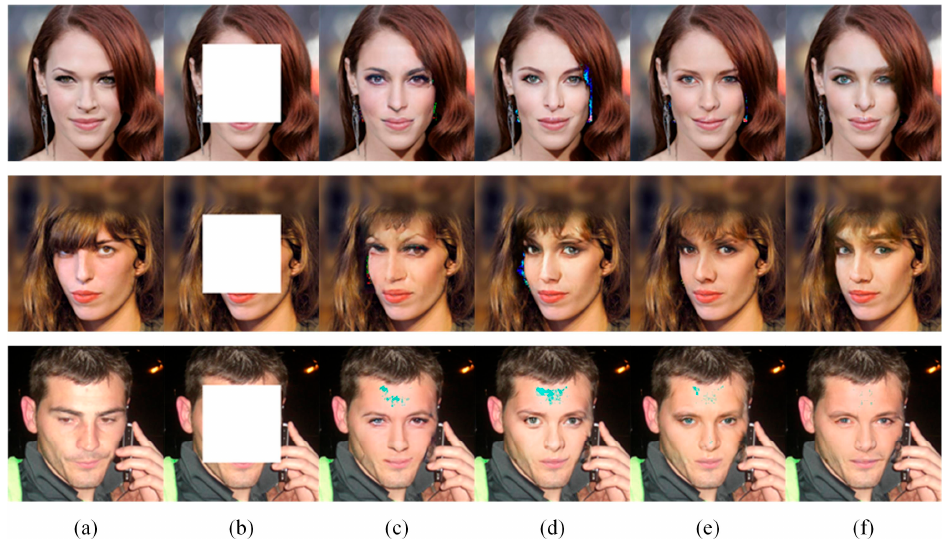
Figure 5. Ablation experiment on randomly masked square: ( a ) Ground truth; ( b ) Input image; ( c ) Non-transformer two-layer network + loss function; ( d ) Two-layer transformer + loss function; ( e ) Two-layer transformer + adaptive multi-head attention mechanism; ( f ) Two-layer transformer + adaptive multi-head attention mechanism + loss function.